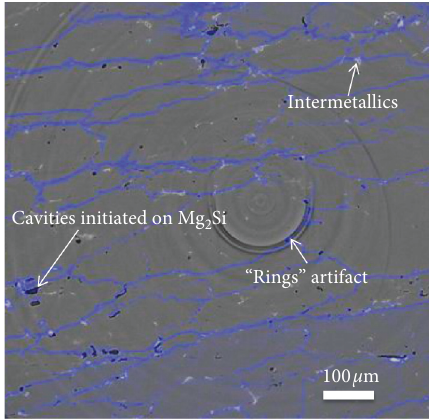
Figure 3: Reconstructed 2D image showing coarse Mg cipitates, iron-rich intermetallics, and grain boundaries obtained by superposition of tomography images performed on the sample before and after gallium wetting. “Rings” artifact is also visible on the